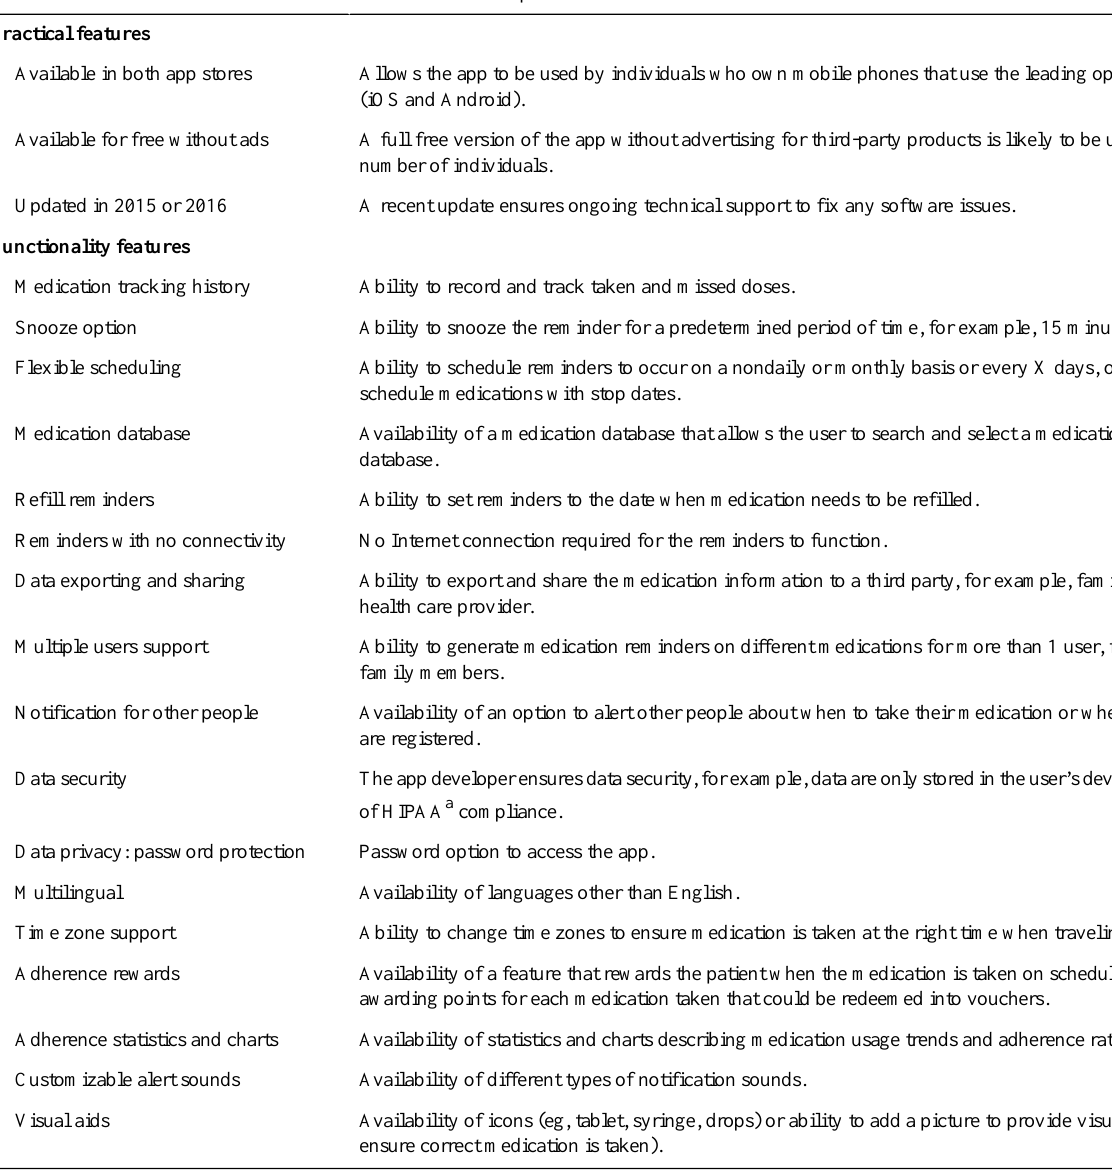
Rationale or descriptionFeatures